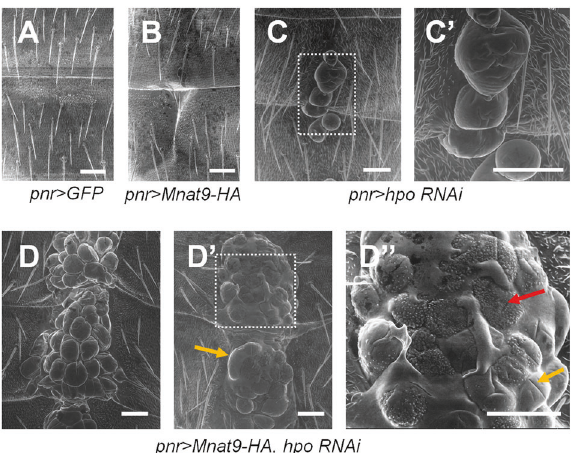
Fig. 6 SEM images of tumorous tissue growth in the abdomen caused by Mnat9 overexpression and Hpo depletion. A Control. B Overexpression of Mnat9 by pnr-Gal4 causes mild cleft in the abdominal midline. C , C ′ Knockdown of hpo induces a small number of tumorous tissues with relatively smooth surfaces in the medial part of the abdomen. D – D ″ Mnat9 overexpression combined with hpo knockdown induces massive tumorous tissues protruding from the abdominal midline. Overgrown tissues show either smooth surfaces (yellow arrow) or roughened surfaces with granular protrusions (red arrow). Scale bars: 50 μ